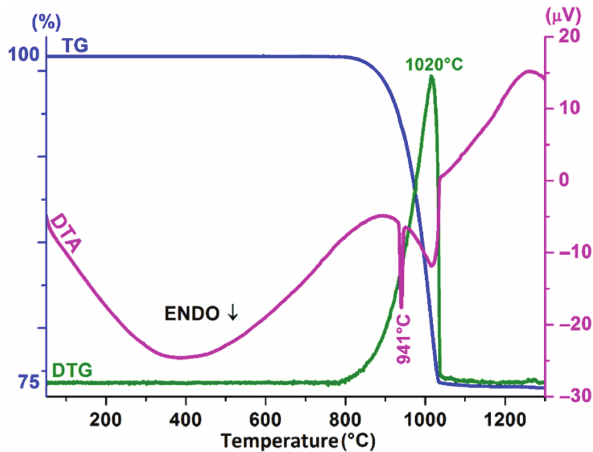
Figure 2: DTA/TG/DTG curves of Sr 3 SiO 5 : Eu 3+ , Dy 3+ , Mg 2+